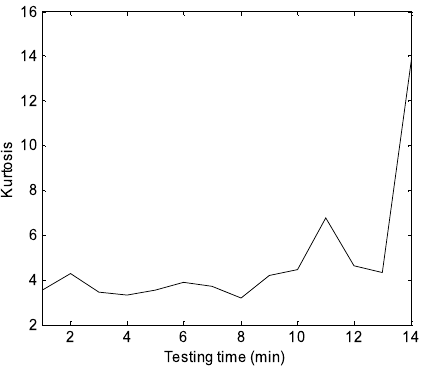
Fig. 10. Variation of kurtosis values of the residual vibrations recorded during the fatigue test.